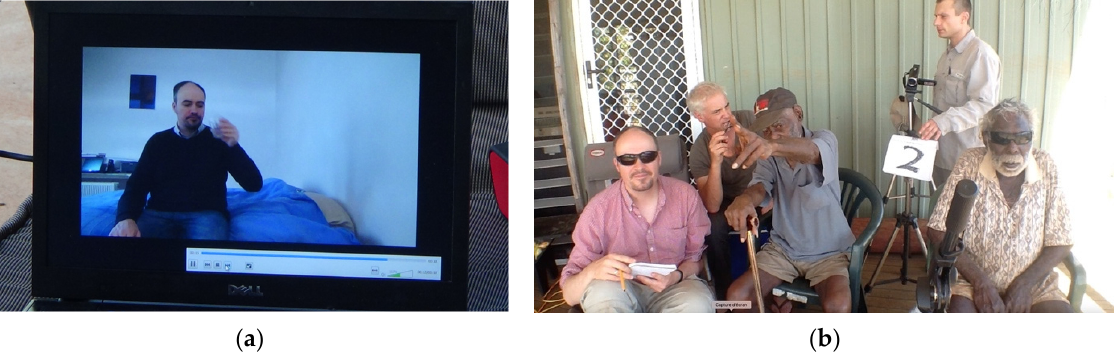
Figure 3. picture ( a ) shows a stimulus as seen by the informants, while picture ( b ) shows a typical set up (with from left to right: linguists Patrick Caudal and Bruce Birch, informant KM, linguist Rob Mailhammer, and informant AB; this photograph was taken on 11 July 2013 at Adjamarduku out- station, Croker Island).